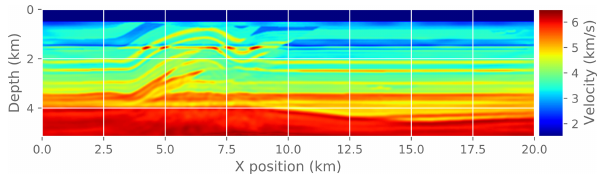
Figure 15. Reference solution for the complete FWI problem. This is the solution after running reference FWI for 30